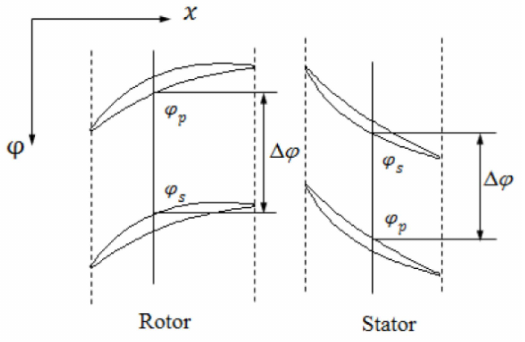
Figure 1. Schematic diagram for the passage of rotor and